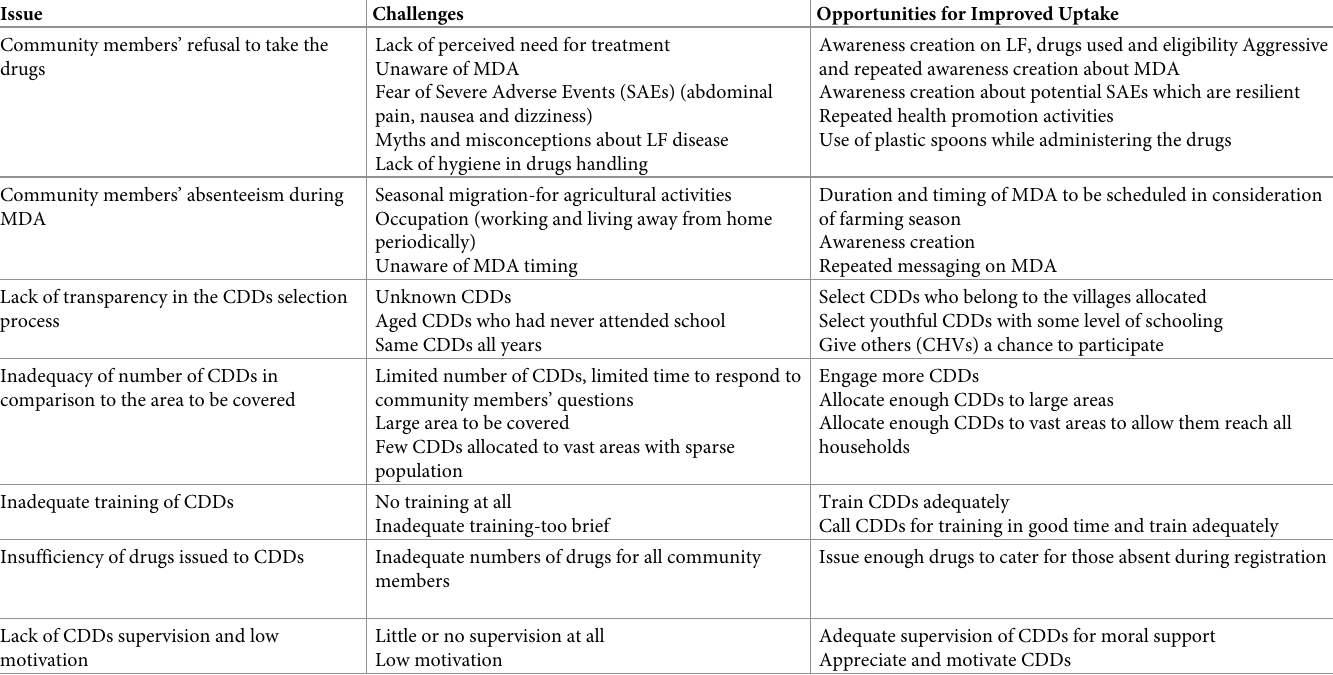
Table 2. Implementation challenges and opportunities for improved